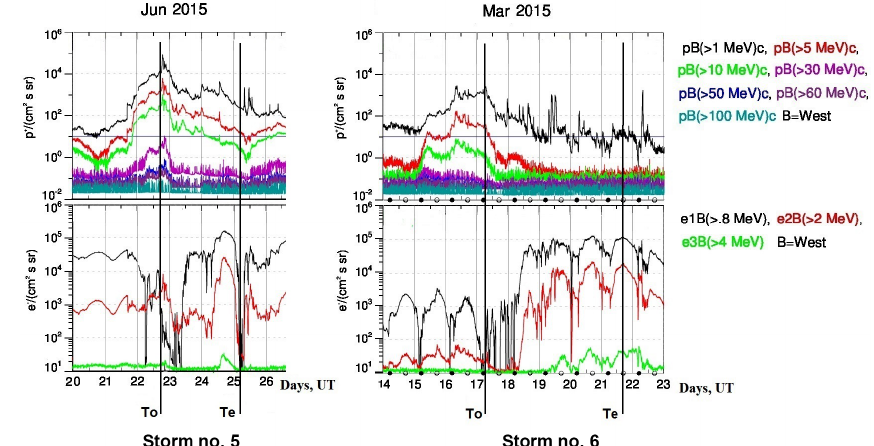
Figure 7. GOES satellite data for storms no. 5 and 6; p: protons, e: electrons. The particle energy is labeled by different colors. The beginning (To) and the end of the storm (Te) are marked by vertical